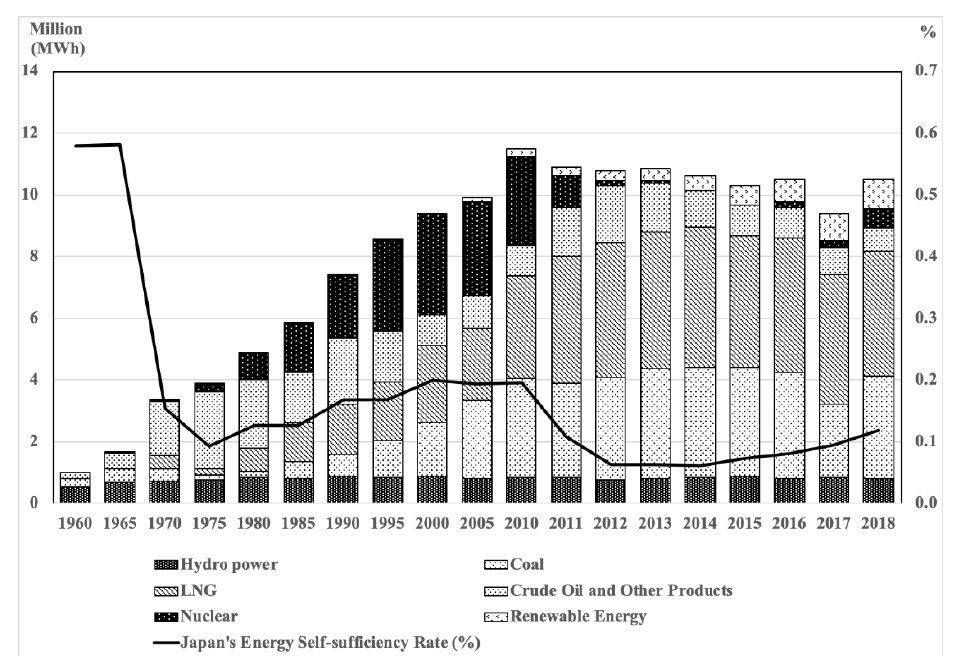
Figure 1. Transitions in the primary energy supply of Japan, 1970–2016 (source: Ministry of Economy, Trade and Industry, 2018 [37]).